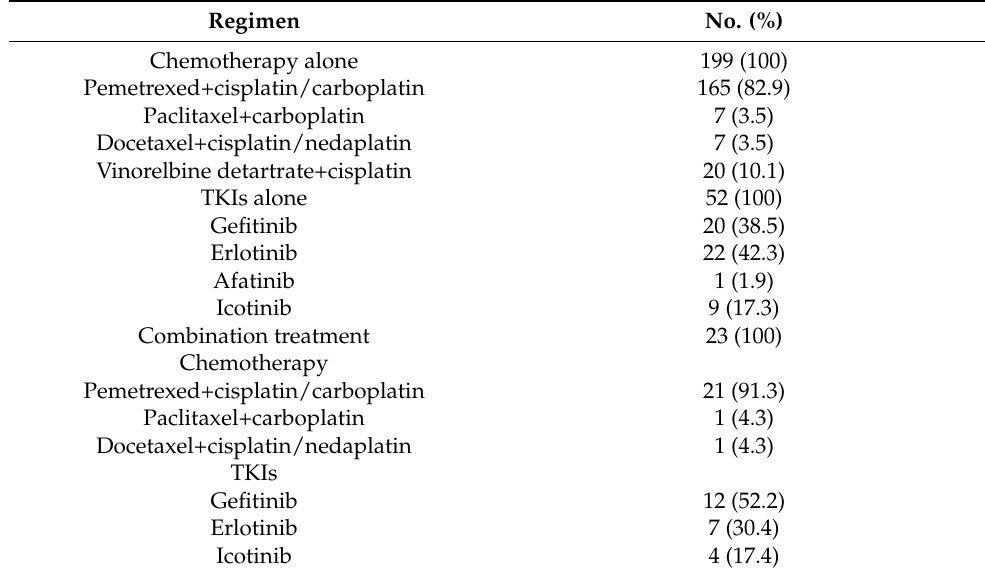
Table 2. Adjuvant systemic